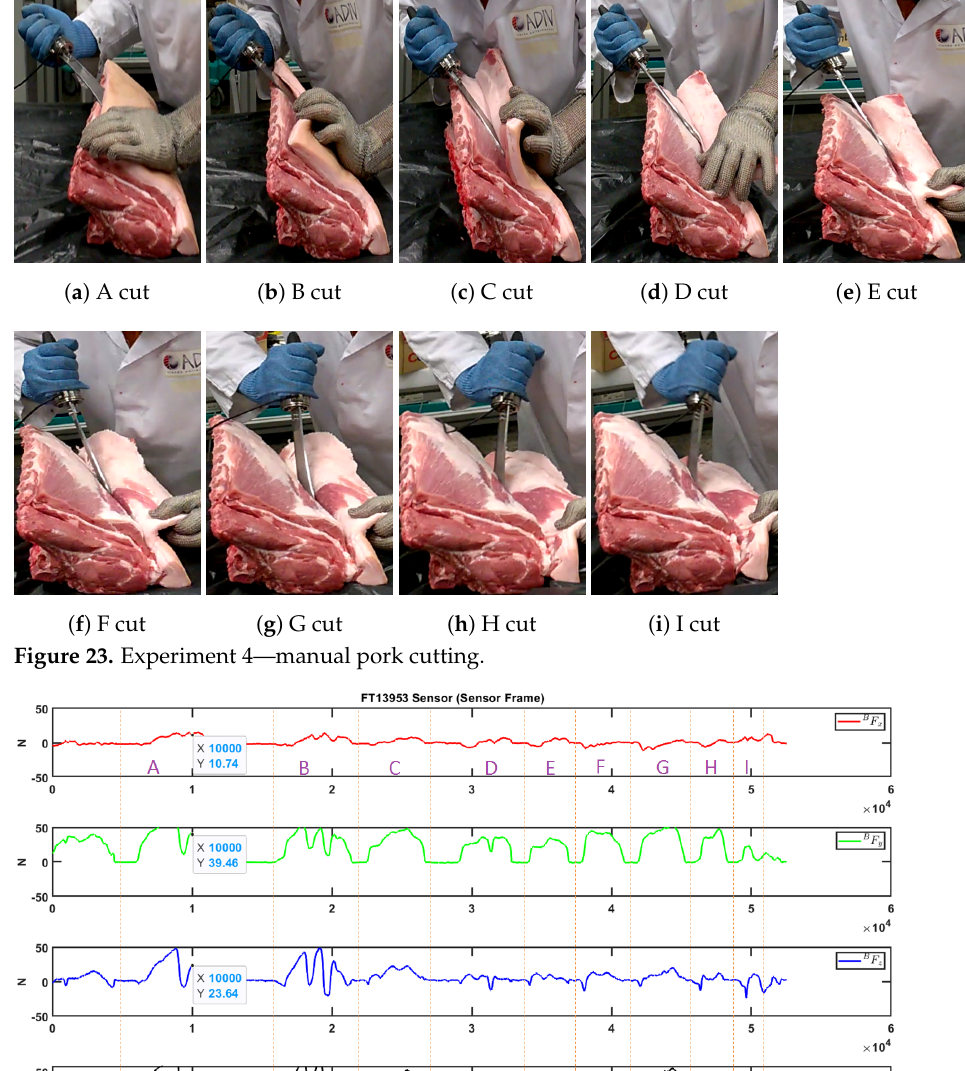
Figure 24. Forces applied by the user in Experiment